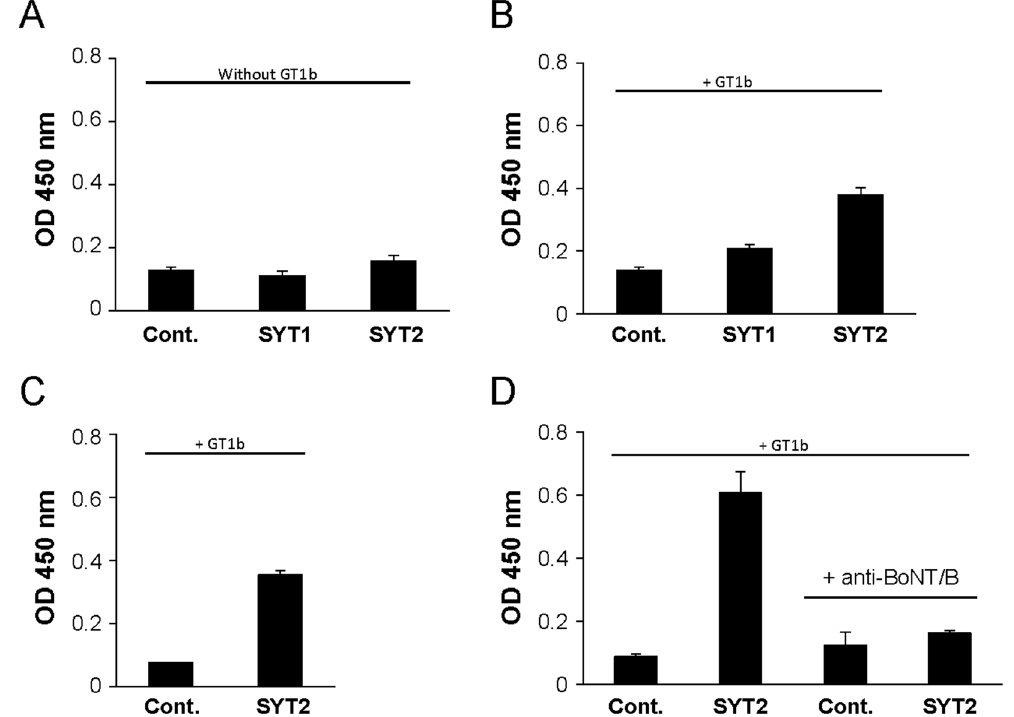
Figure 4. ELISA detection of BoNT/B interaction with exoSYT. ( A , B ) ExoSYT1, exoSYT2 and exoAMA1 (Cont) were directly coated on ELISA plates then loaded with ( B ) or without ( A ) GT1b and incubated with BoNT/B (10 nM). Binding was revealed using an anti-BoNT/B antibody. Results are representative of 5 (p > 0.05) ( A ) and 6 (p < 0.05) ( B ) independent experiments. ( C ) HcB (10 nM) binding to exoSYT2/GT1b was measured as described for BoNT/B representative of 2 independent experiments. ( D ) Same as in ( B ) but binding was performed in presence of 25% human serum. BoNT/B binding specificity was assessed